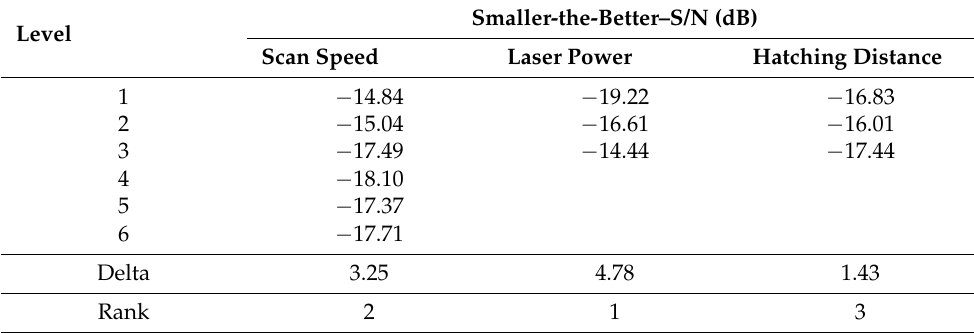
Table 6. Average S/N ratios.